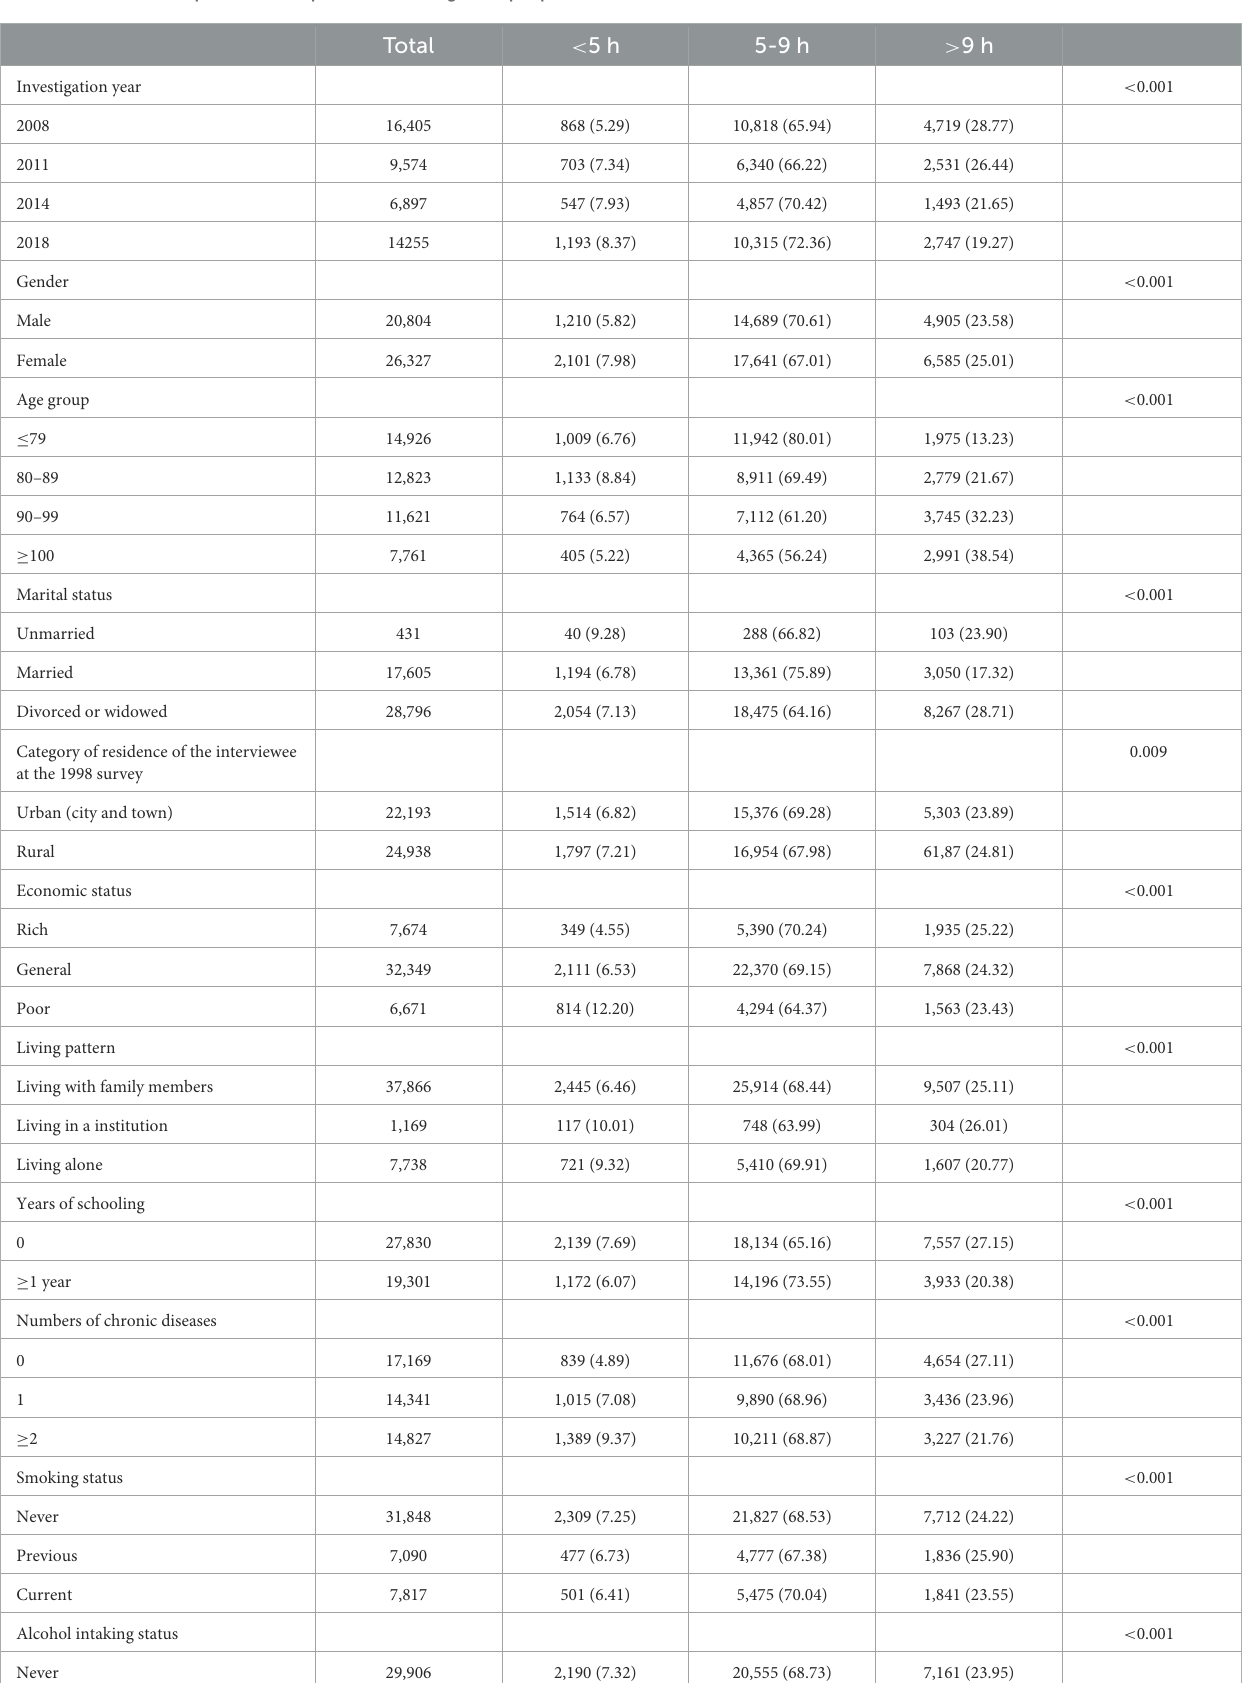
TABLE 2 Trends and disparities in sleep duration among older people in China from 2008 to 2018.